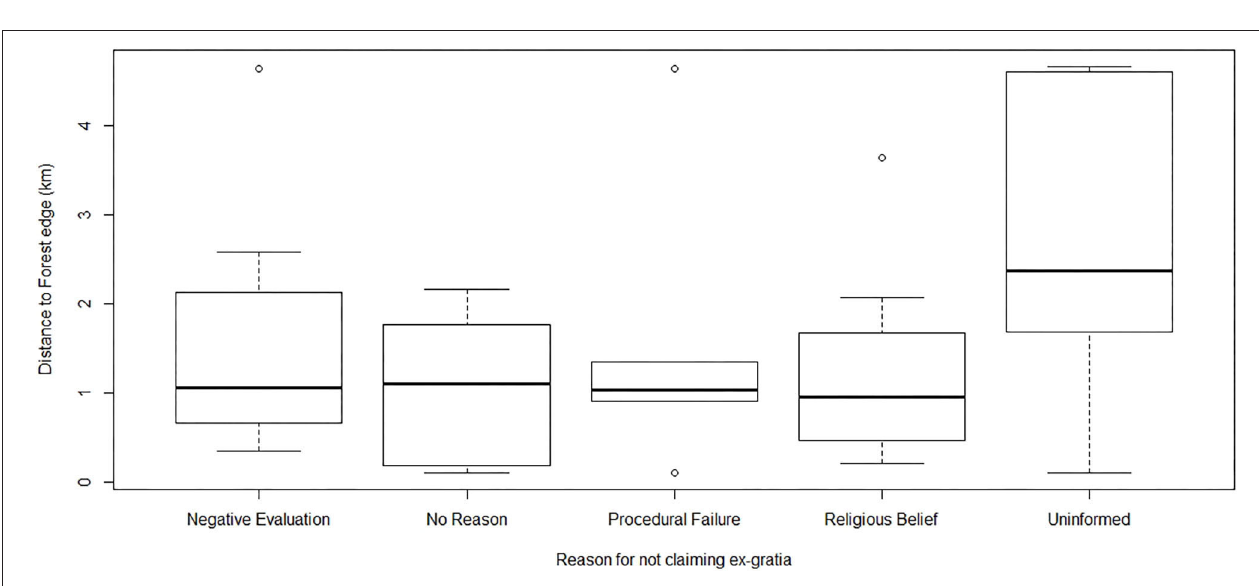
FIGURE 3 | The box-plot showing the effect of distance to forests on the reasons for crop loss as reported by respondents. Distance to forest is plotted on the y-axis in kilometer.